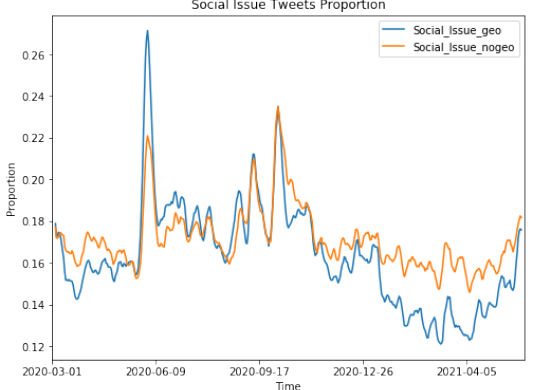
Figure 2. NPI topic proportions: geo-tagged vs. non-geo-tagged.